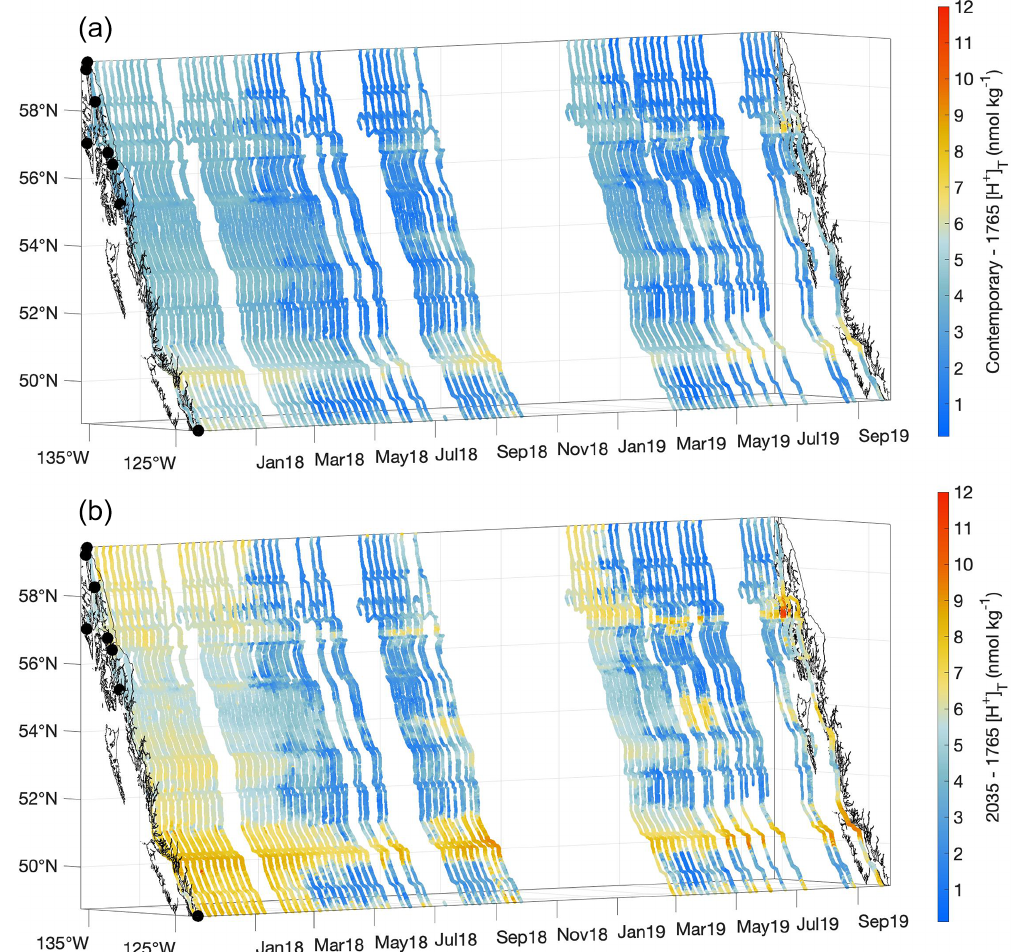
Figure 9. Contemporary [H + ] T values minus the estimated values for 1765 (nmolkg − 1 ; a ) and the estimated values for 2035 minus the 1765 values (nmolkg − 1 ; b ). The x and y axes represent longitude and latitude, respectively, and with the coastline and terminal positions shown as in Fig. 1 and time increasing along the z